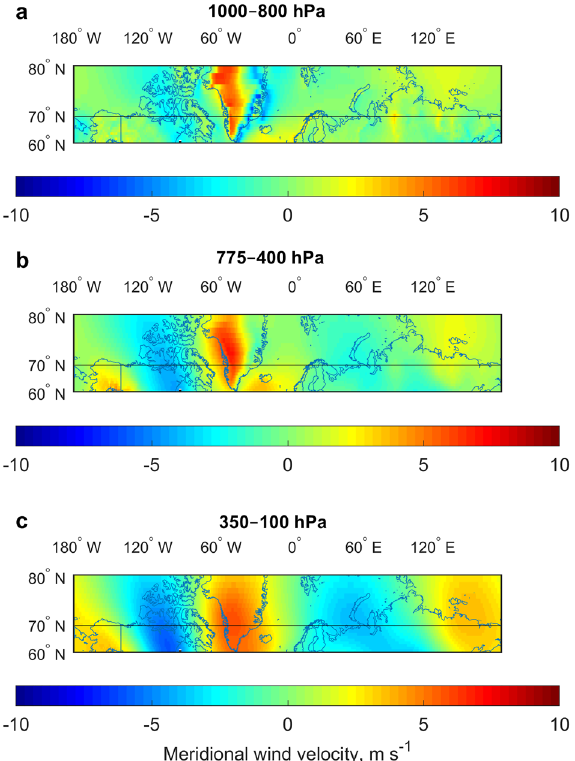
Figure 1. Mean meridional component of wind velocity (m s −1 ) for the region 60°–80°N in the different atmospheric layers averaged for 1950–2019. ( a ) 1000–800 hPa. ( b ) 775–400 hPa. ( c ) 350–100 hPa. Positive values indicate northward direction. The reference lines are drawn at the 70°N. Mercator map projection is used. The Matrix Laboratory (MATLAB) with version R2017b (https:// www. mathw orks. com/) was used to generate this